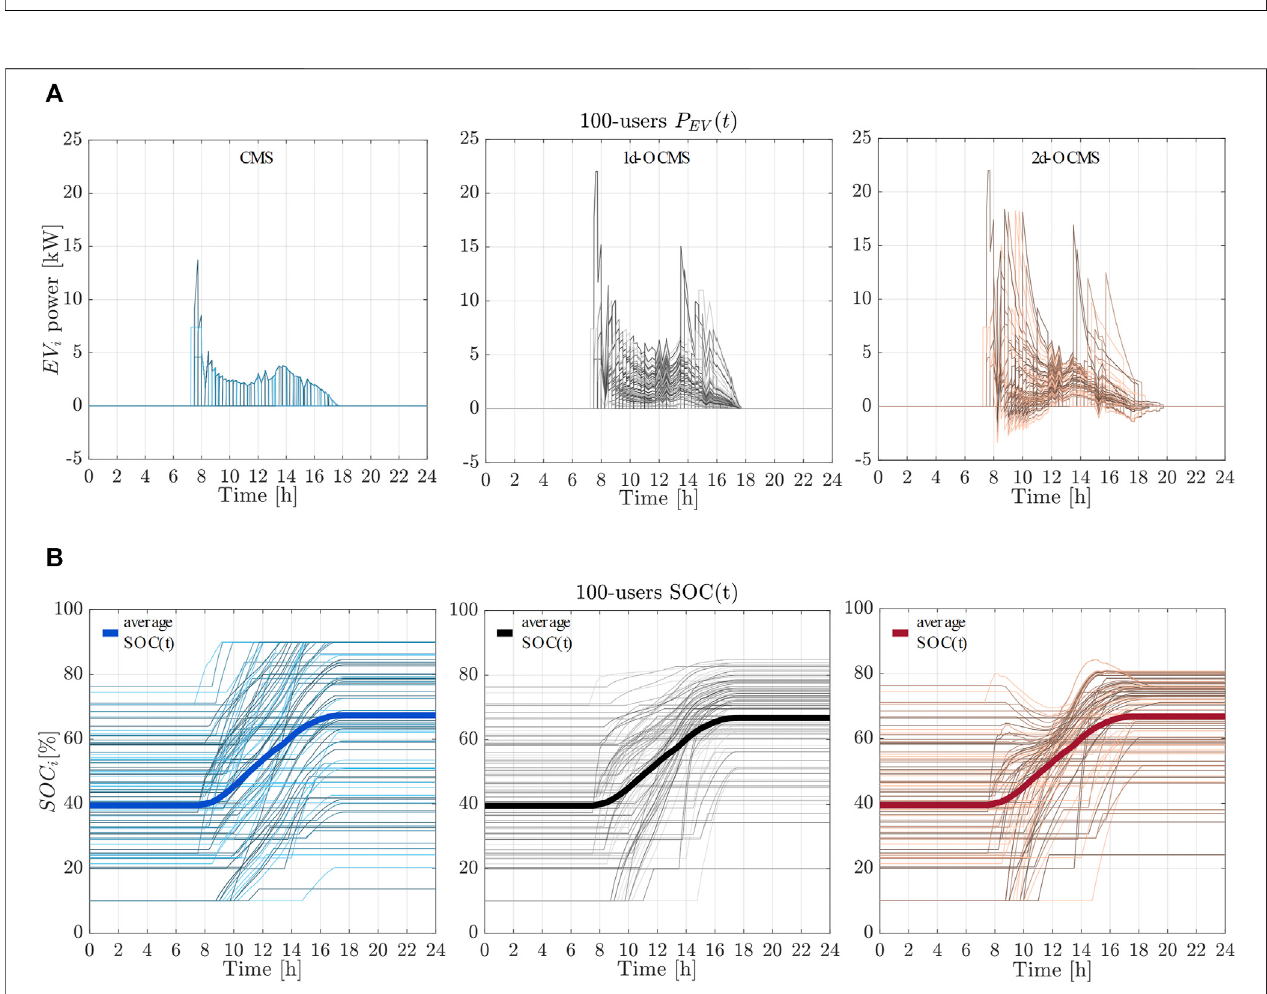
FIGURE9| EVpopulation(100users)chargingpower pro fi le (A) andSOCevolution (B) asafunctionofthetime,incaseofstandardCMS (leftframes, bluetint) , 1d-OCMS (center frames, gray tint) , and 2d-OCMS (right frames, orange tint) on a 24 h period. Each line in (A) depicts the power value P EVi ( t ) of a vehicle belonging to the examine 100-user population. Then, each line of (B) depicts the SOC i ( t ) evolution of the i -th EV.